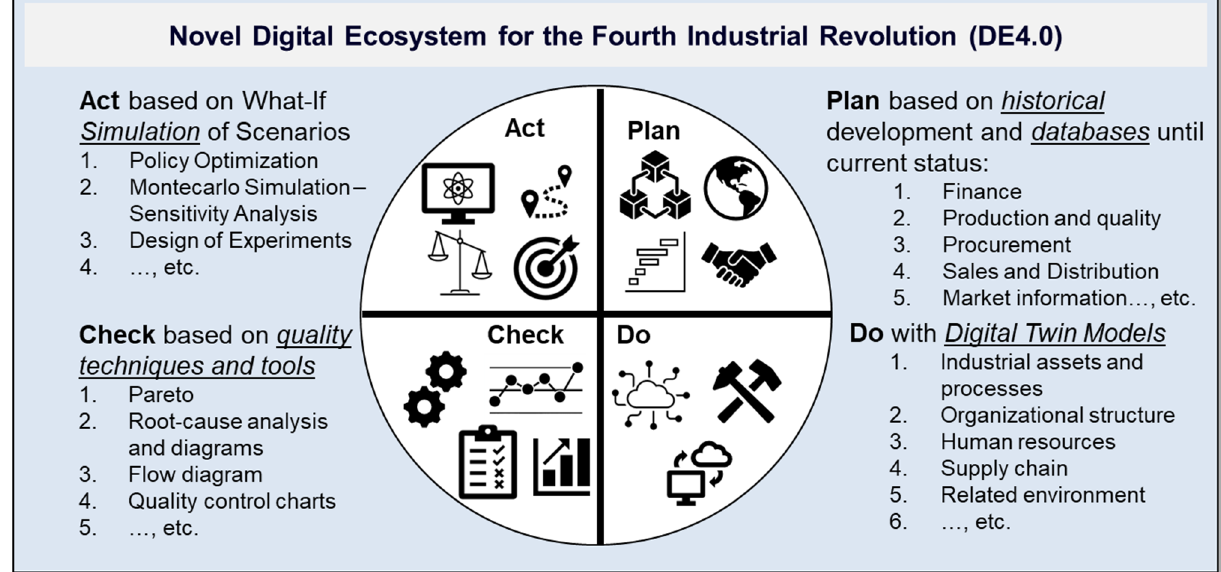
Figure 6. A Digital Ecosystem for the Fourth Industrial Revolution (DE4.0) (own elaboration).